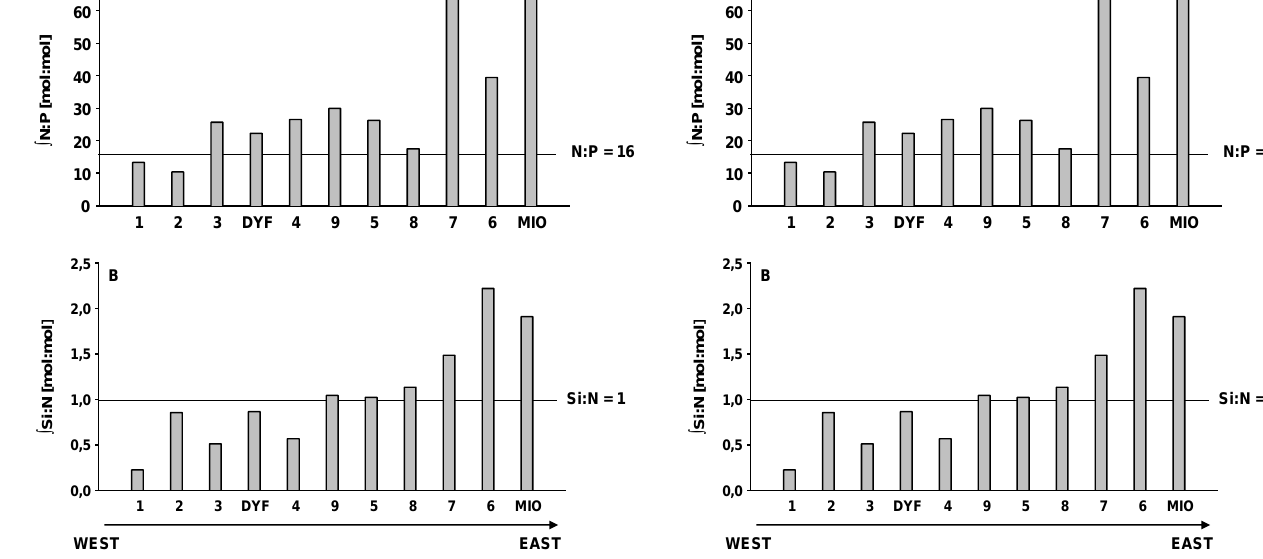
Fig. 12. Integrated N:P (A) ) and Si:N (B) ratios (mol:mol) over 0–150m for the PROSOPE cruise along a West-East gradient. In- tegration made under 150m is signified by a red star. Integration at stations 1 and 2 was made over 100 and 110m respectively.